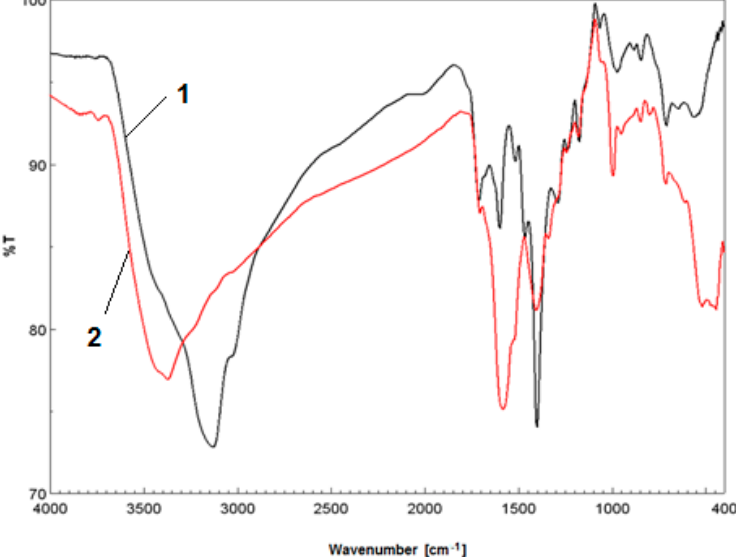
Figure 4. Overlapped FT-IR spectra of 5,10,15,20-tetrakis-4-aminophenyl-porphyrin ( 1 ) and its Zn-metallated derivative in KBr pellets ( 2 ).